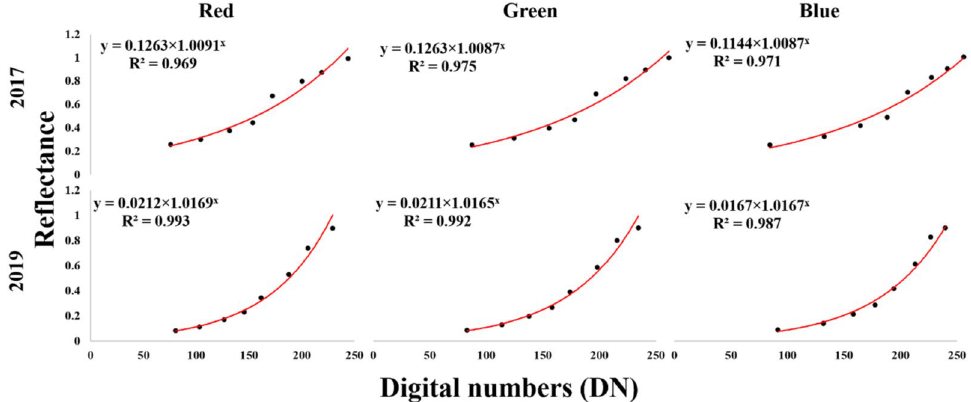
Figure 4. Regression curves of reflectance ( x axis) vs digital numbers (DN) ( y axis) from aerially taken red– green–blue (RGB) images over 2017 and